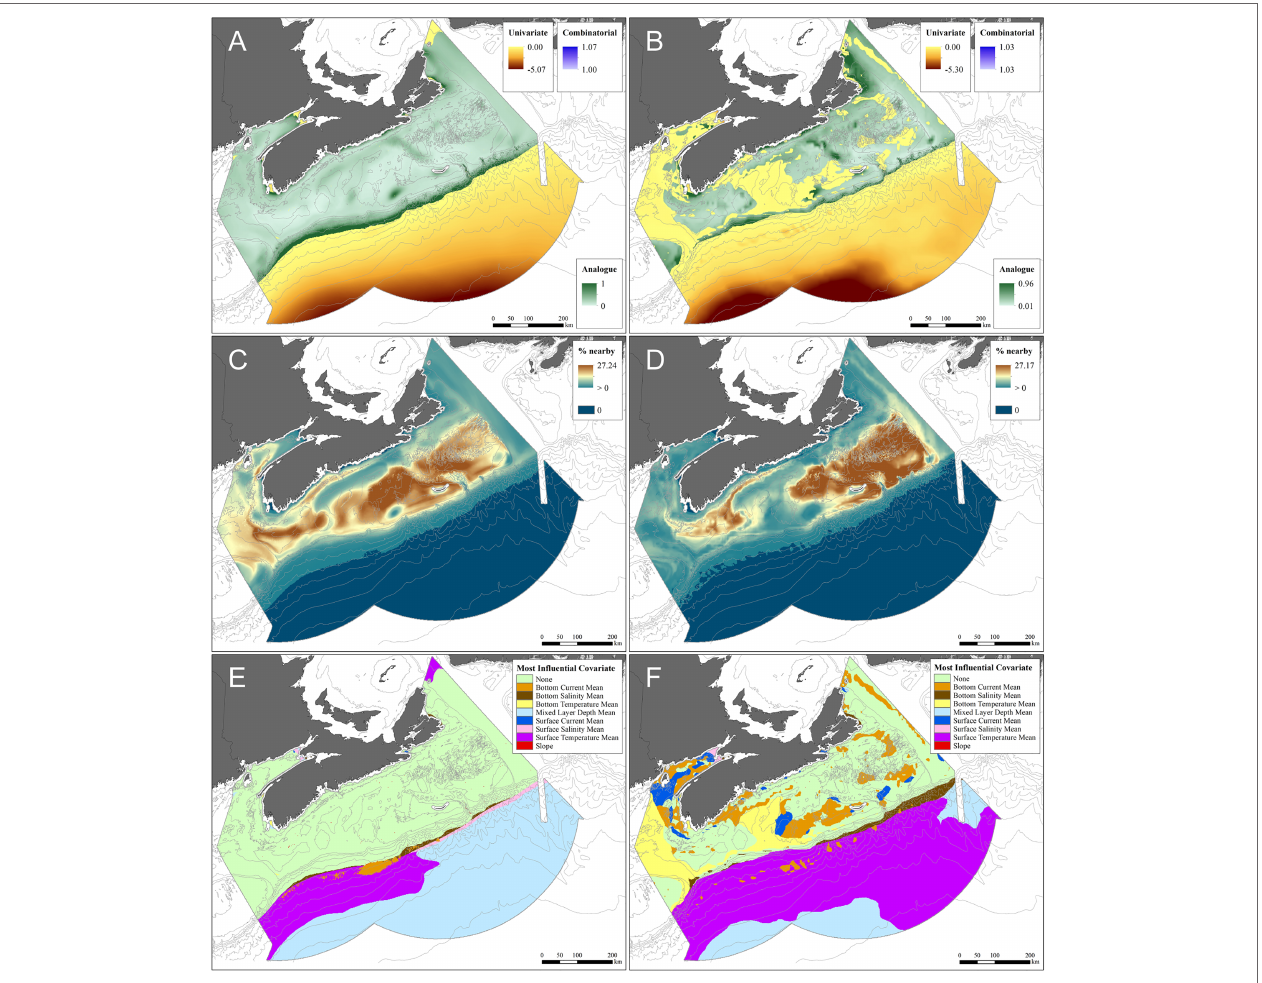
FIGURE 7 | Areas of extrapolation defined by eight input covariates under present-day (A, C, E) and 2046–2065 RCP 4.5 (B, D, F) conditions, using both presence and absence data. (A, B) Extrapolation quantified by the Extrapolation Detection tool (ExDet); (C, D) Percentage of data nearby (% Nearby), with areas where predictions are potentially unreliable shaded in dark blue; (E, F) Areas of extrapolation identified by their most influential covariate. (Areas with analogous conditions are shaded light